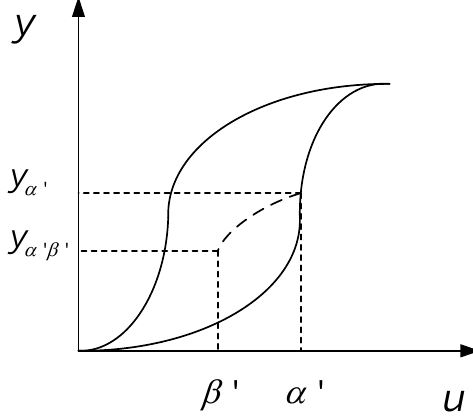
Figure 10. First-order reversal descending curve.